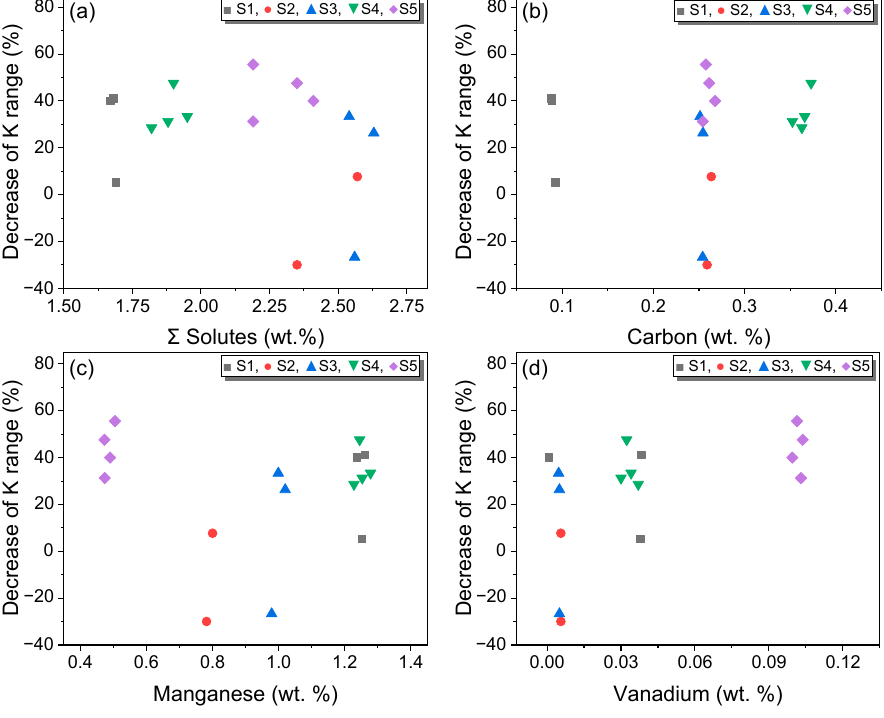
Figure 10. The decreasing percentage of carbon segregation ( K ) range in the radial direction of the billet via solute content: ( a ) total solute content; ( b ) C; ( c ) Mn; ( d ) V.